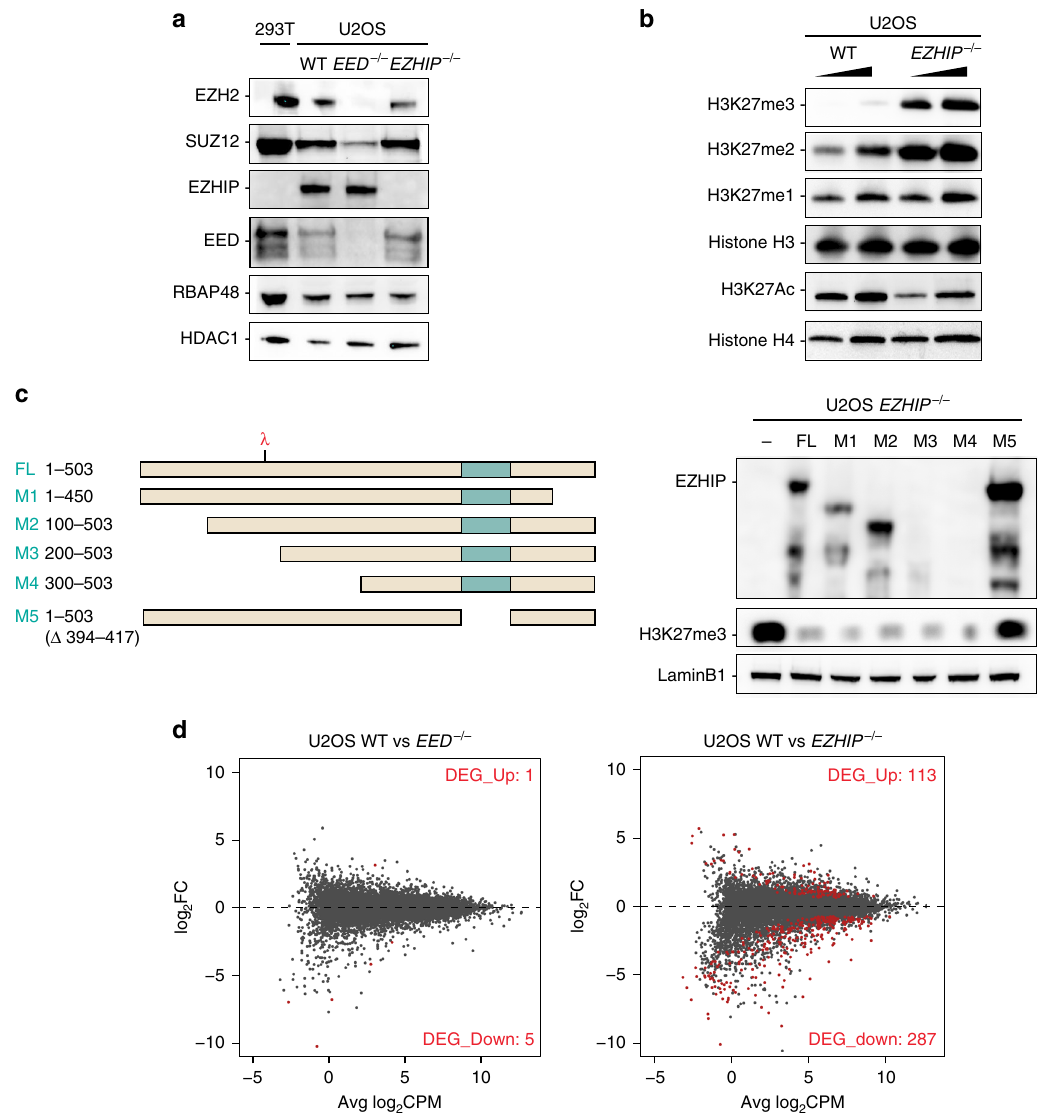
Fig. 2 EZHIP inhibits H3K27me3 deposition. a Western blot analysis of PRC2 core complex subunits (SUZ12, RBAP48, EED, and EZH2), EZHIP and HDAC1 (loading control) on U2OS nuclear extracts WT, EED − / − , and EZHIP − / − . b Western blot analysis of H3K27 methylation: H3K27me1, H3K27me2, H3K27me3, H3K27ac and, H3 and H4 (loading controls). c Scheme representing EZHIP mutants (left panel) stably reintroduced in U2OS EZHIP − / − line. The red lambda indicates the epitope recognized by antibody detecting EZHIP protein. Western blot analysis (right panel) of cell lines expressing EZHIP FL or mutants probed with antibodies indicated on the left. d Mean-difference plot showing average log2 counts per million (logCPM) vs. log2 fold-change (logFC) expression between U2OS WT and EED − / − 69 or U2OS WT and EZHIP − / − (right). Right corner: the number of genes signi fi cantly differentially expressed (FDR < 0.05) corresponding to the dots colored in red. n =